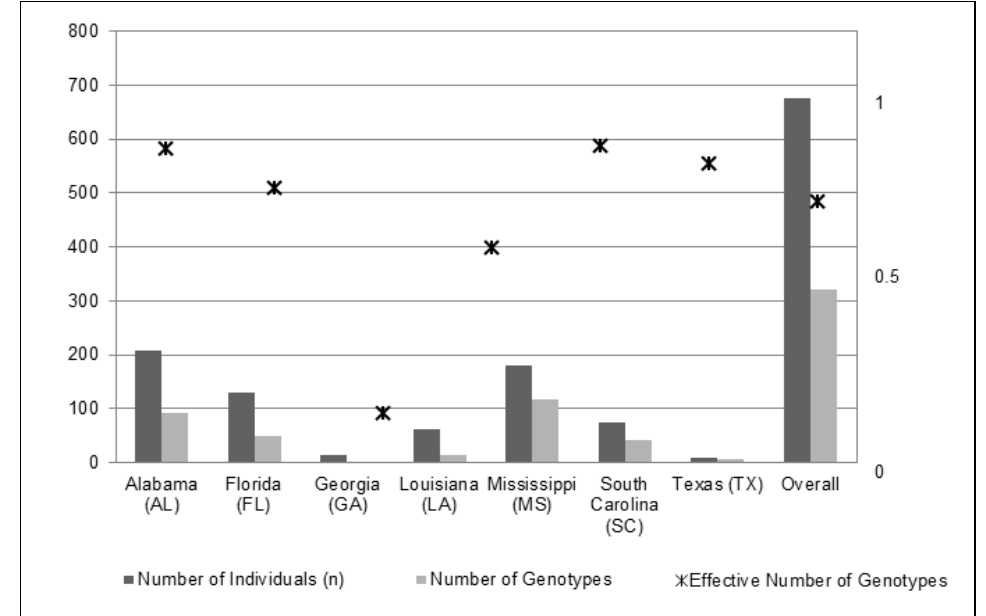
Figure 1. Genotypic diversity relative to the number of individual samples in each state and